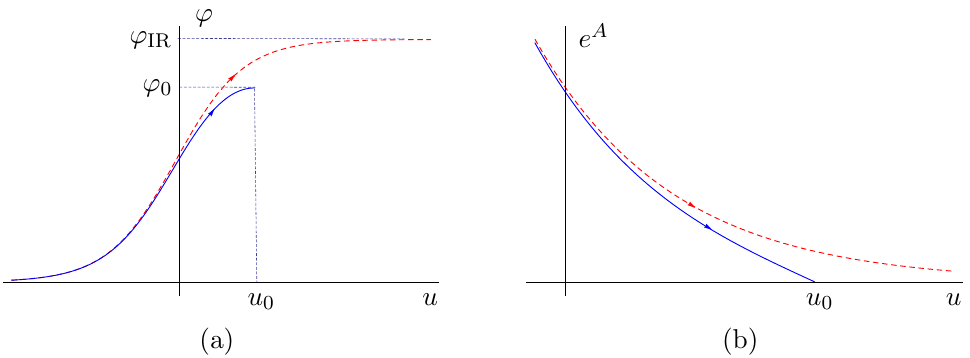
Figure 2 . The scalar (cid:12)eld (a) and scale factor (b) pro(cid:12)les of a positive curvature RG (cid:13)ow geometry (solid lines). Both the scale factor and the scalar (cid:12)eld have an IR end point at u = u 0 , ’ = ’ 0 . The corresponding zero-curvature solutions extending to the conformal (cid:12)xed point ’ = ’ IR (dashed lines) are shown for